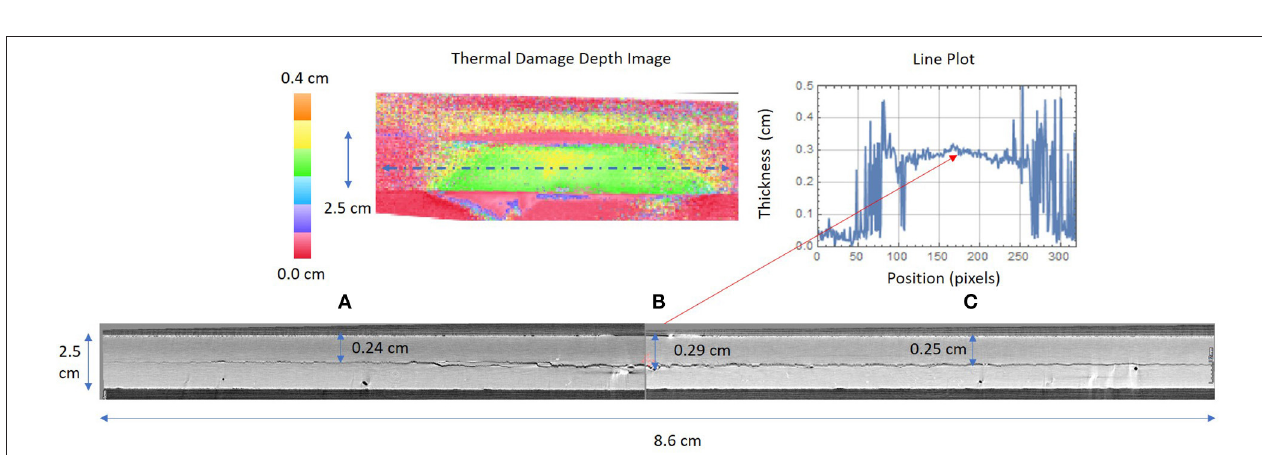
FIGURE 13 | Thermal damage depth image and line plot for small delamination with comparison to X-ray CT cross section slice. At three different locations (A–C) .